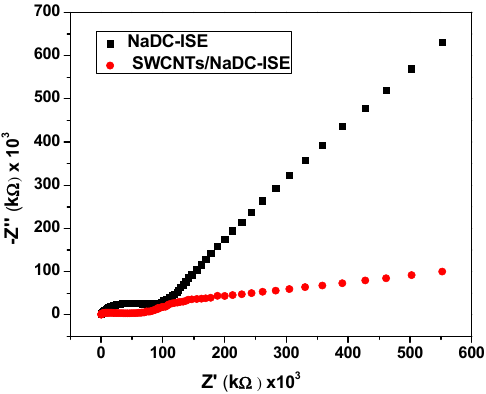
Figure 8. Impedance for NaDC / MIP–ISEs with and without SWCNTs as a solid contact material.